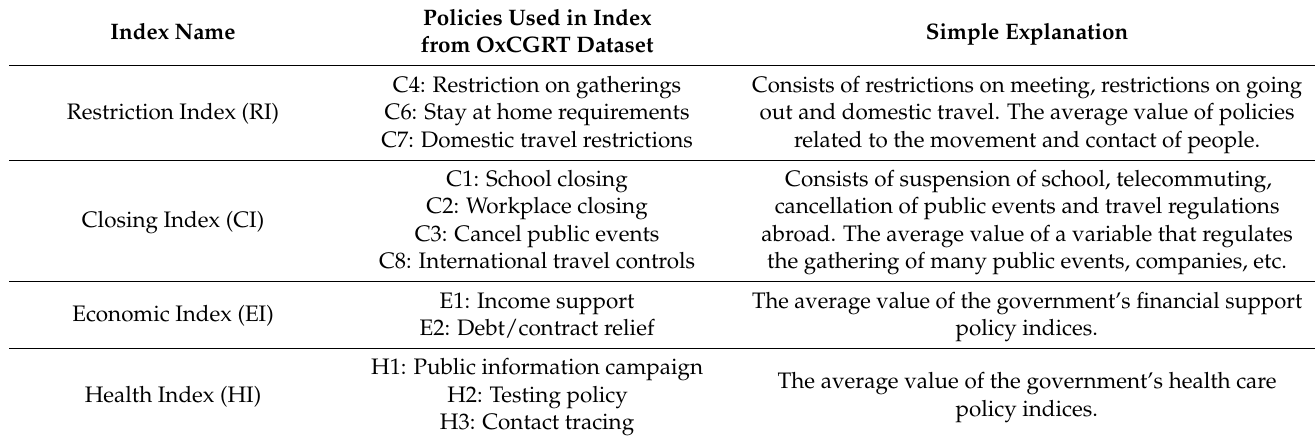
Table 1. Polices used for the calculation of the Indices. The Korean government index represents the Korean government’s social distancing levels implemented during the course of the pandemic by the Korean